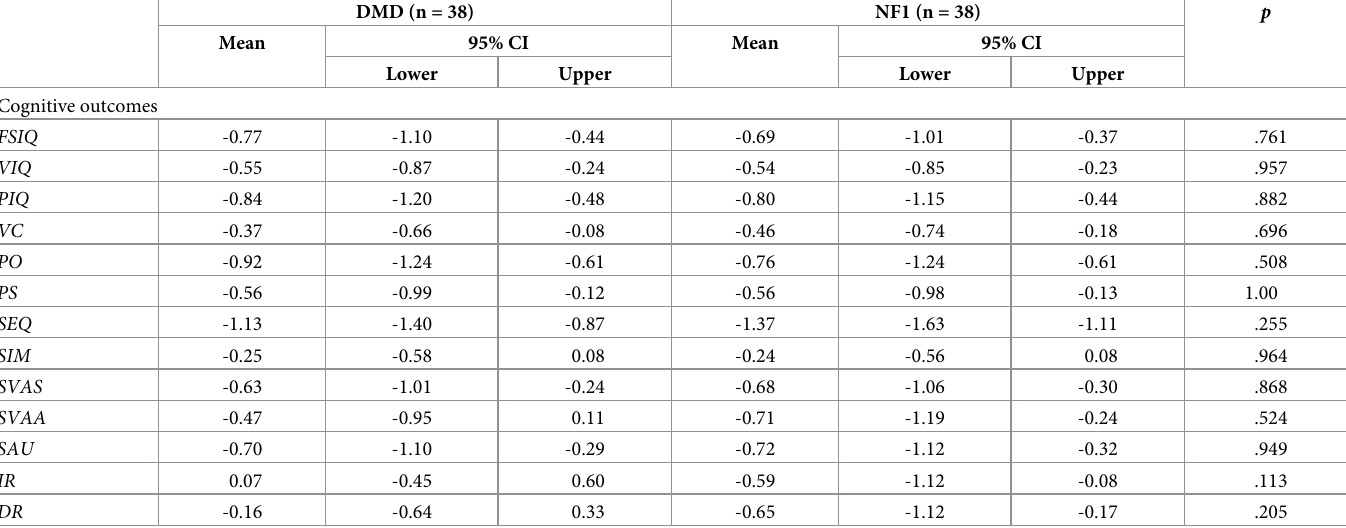
Table 4. Multivariate analyses of cognitive outcomes of the DMD and NF1